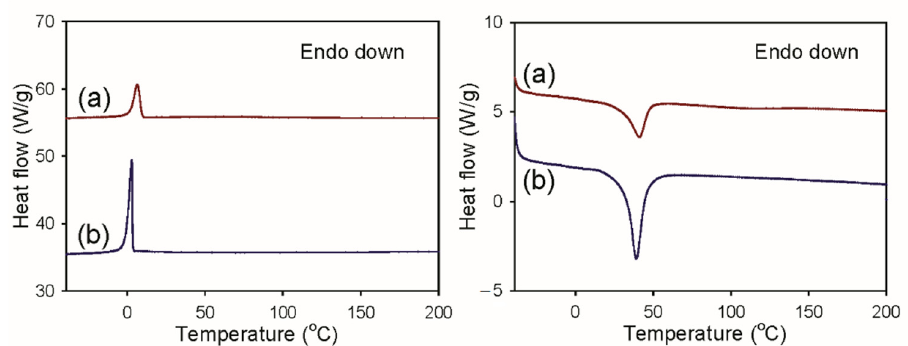
Figure 3. DSC crystallization curves ( left ) and second melting curves ( right ) of the PU-BDO ( a ), and the PU-DMPA ( b ).